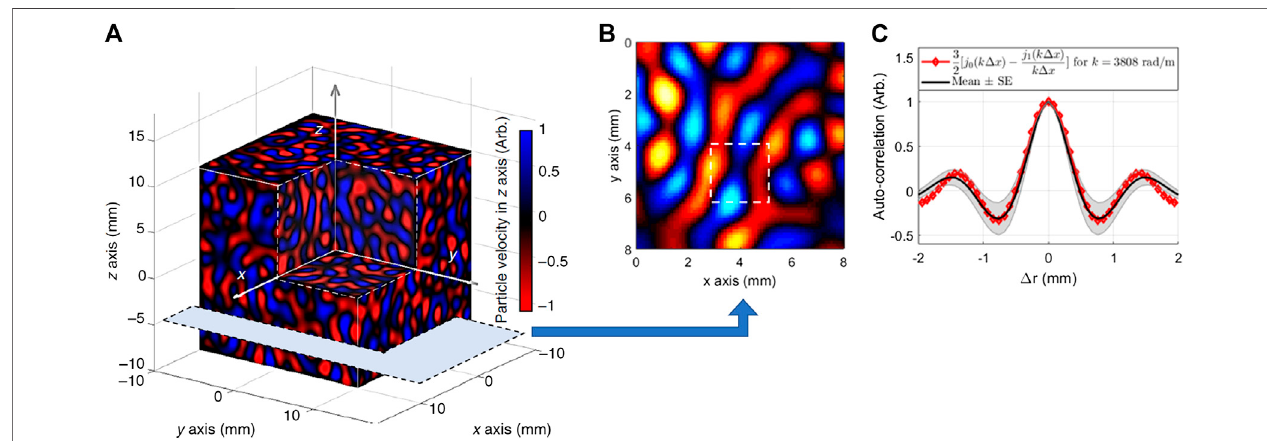
FIGURE 2 | (A) Particle velocity fi eld along the z -axis after conducting a Monte Carlo analysis of reverberant shear waves at an arbitrary time t 0 . The cube dimensions are 20 × 20 × 20 mm 3 . The simulated media is a uniform elastic material. The applied vibration was at frequency of f 0 (cid:2) 2 kHz, and a constant shear wave speed c s (cid:2) 4 m/s.Forthissimulation,atotalof10,000realizationsofallrandomvariableswereperformed. (B) Fittingofanalytical Eqs.2 and 3 toautocorrelationpro fi les alongthe x -axis(redline)andthe z -axis(blueline),respectively. (C) Fittingofanalytical Eq.2 toautocorrelationpro fi lesalongthe x -axis(redline)and y -axis(blueline). In all cases, wavenumber k p can be estimated and converted into shear wave speed using c s (cid:2) ω 0 / k p , where ω 0 (cid:2) 2 π × 2000rad / s.